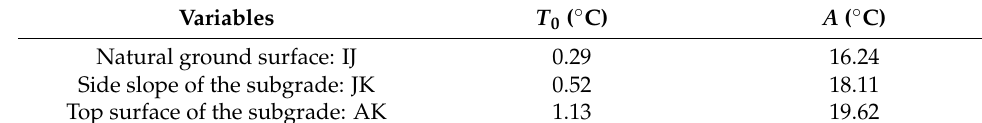
Table 4. Parameters of the temperature boundary conditions.